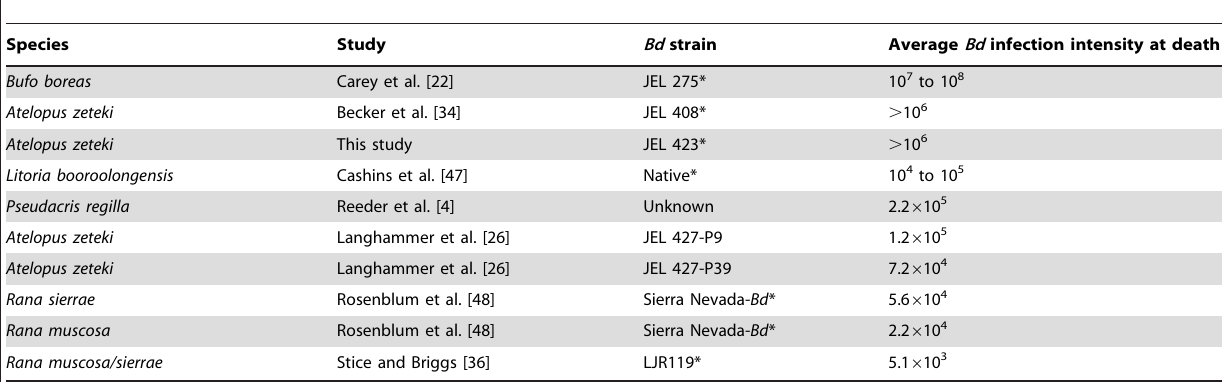
* indicates the Bd strain used occurs within the amphibian species native range.